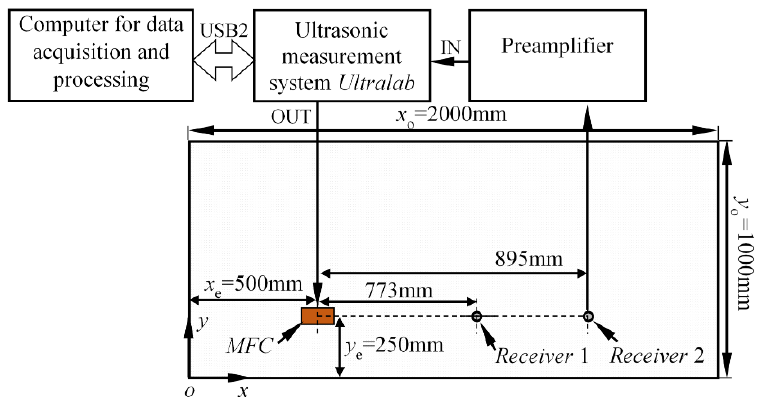
Figure 10. The schematic diagram of the experiments for validation of phase velocity reconstruc- tion approach.